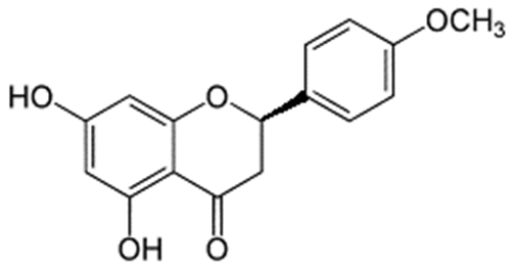
Figure 12. Figure 12. Isosacuranetin. Figure 12. Isosacuranetin.